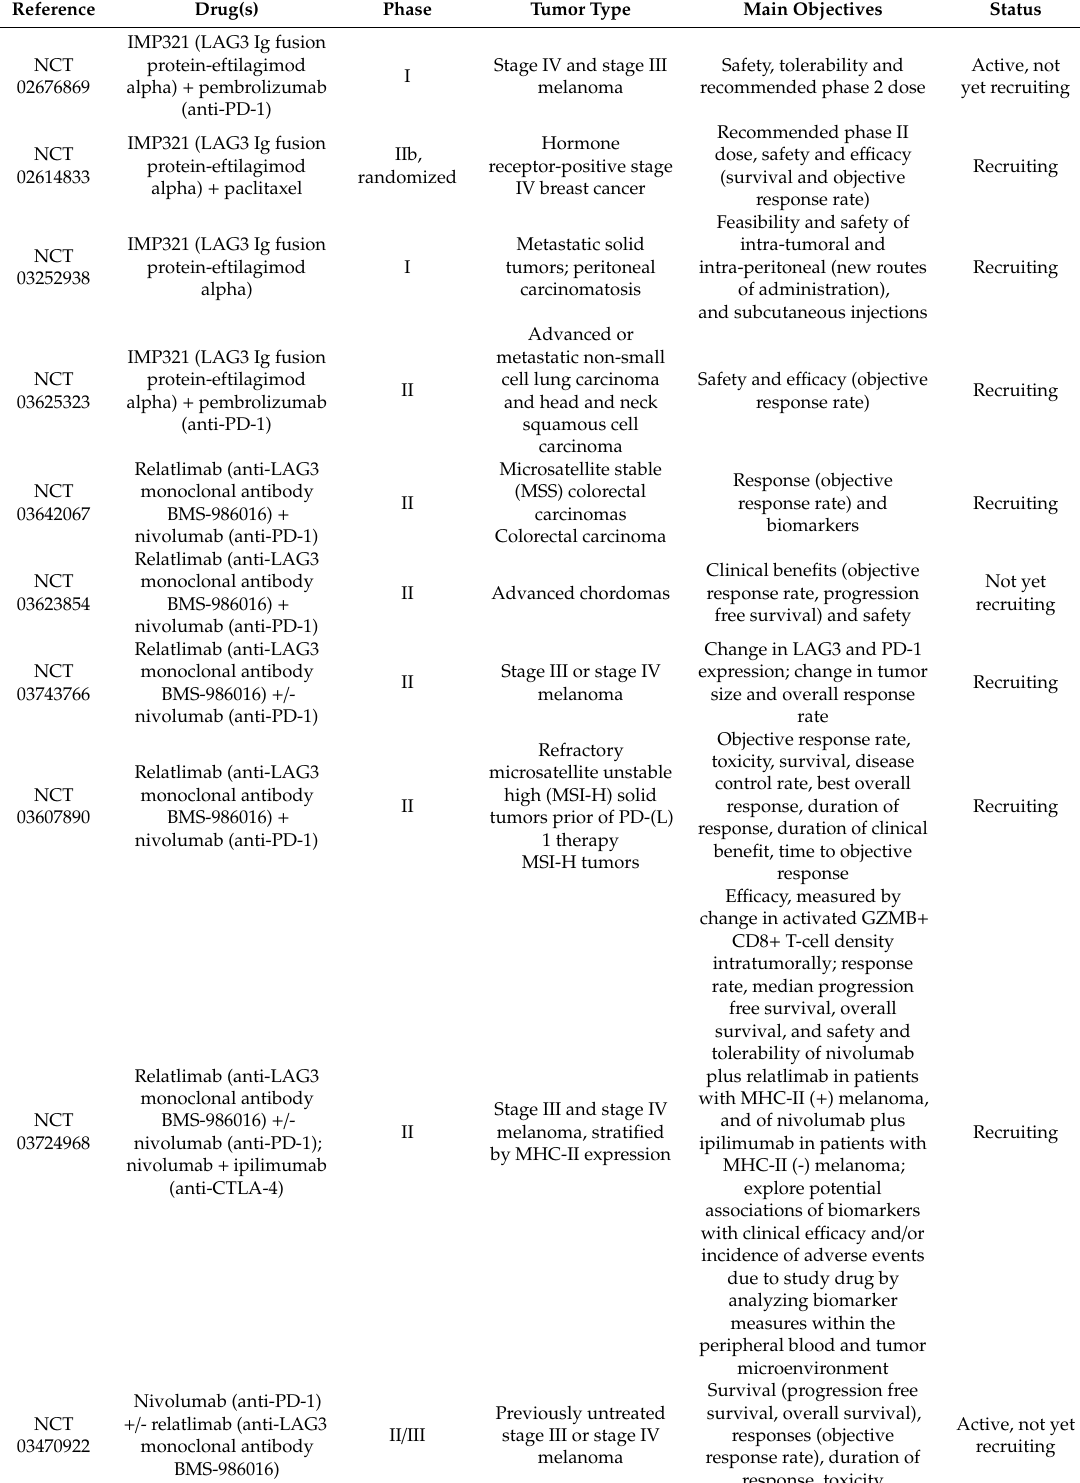
Table 1. Ongoing clinical trials using LAG3 blockade to treat cancer